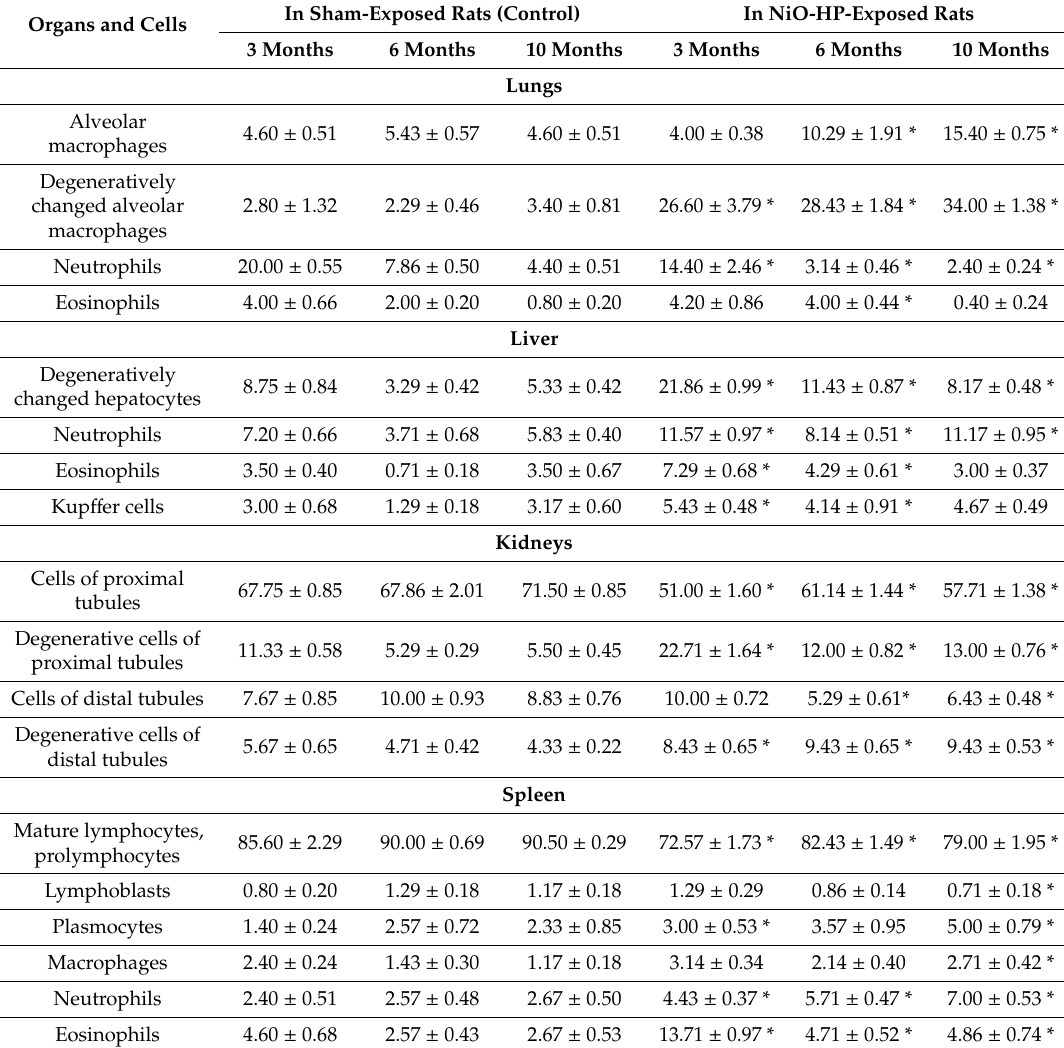
Table 9. Some cytological characteristics of di ff erent organ imprints in rats sacrificed on the next day after the last 4 h inhalation exposure to NiO-NPs at a 0.23 ± 0.01 mg / m 3 concentration; percentage of total cell count ( x ± s.e.